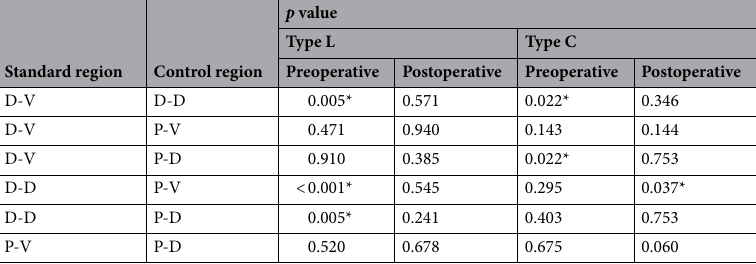
Table 2. Comparative analysis of each region of the sigmoid notch before and after surgery. Kruskal–Wallis test (* p < 0.05). D-V Distal-volar, D-D Distal-dorsal, P-V Proximal-volar, P-D Proximal-dorsal.